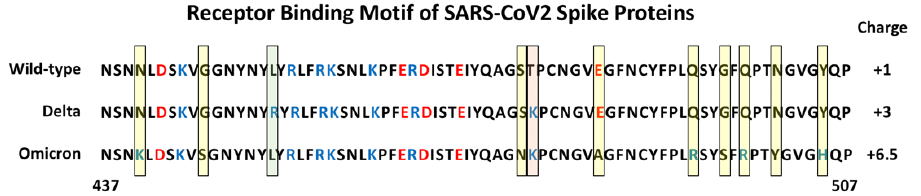
Figure 3. Amino Acid sequence of the Receptor Binding Motif of Spike Proteins. The sequences from position 437 to 507 are shown for the wild-type, and Delta and Omicron variants. The yellow shaded boxes indicate unique mutations in Omicron, the green box indicates a unique mutation in Delta, the pink box indicates a mutation shared by Delta and Omicron. Basic amino acids are colored blue and acidic amino acids red. The estimated charge for each RBM is indicated on the right (+0.5 was assigned to H505 in Omicron Spike).